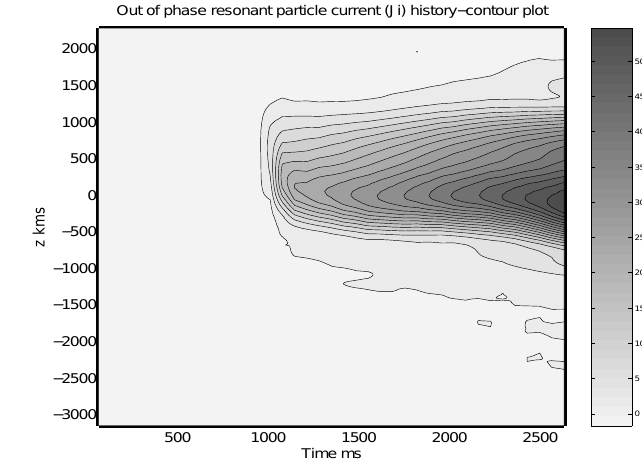
Fig. 12. Run 1. History of out of phase current − J i , which changes the wave phase, in units of J r (lin). The steady increase with time relates to the rising frequency of the emission, increasing resonant electron fluxes, and increasing growth